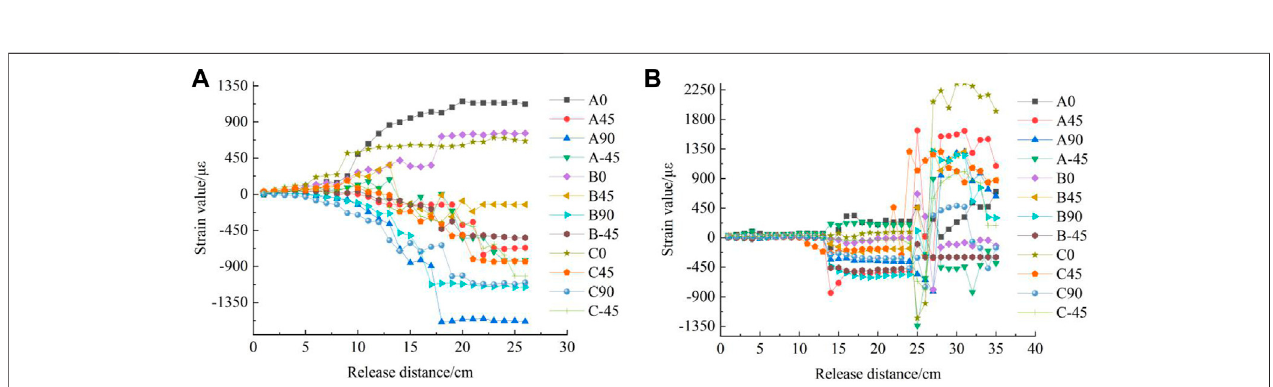
FIGURE 4 | Stress relief process curve. (A) Survey points of the 11 coal track roadway in the West Wing of the Zhujixi mine. (B) Shengyuan mine – 940 return air auxiliary crosscut measuring point.